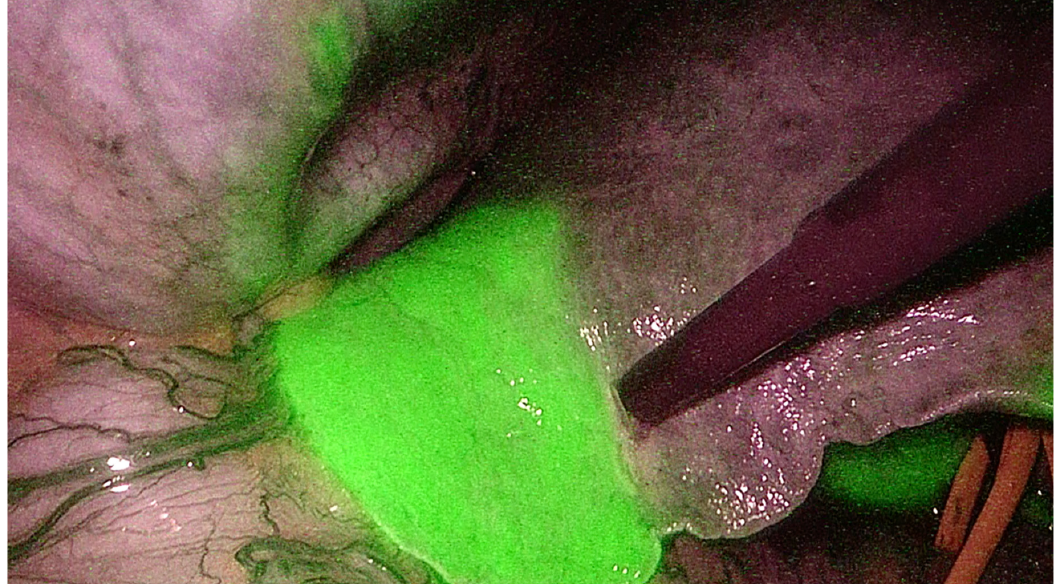
Figure 2. Indocyanine green dye negative staining technique to identify the portal territories during anatomical hepatectomy.